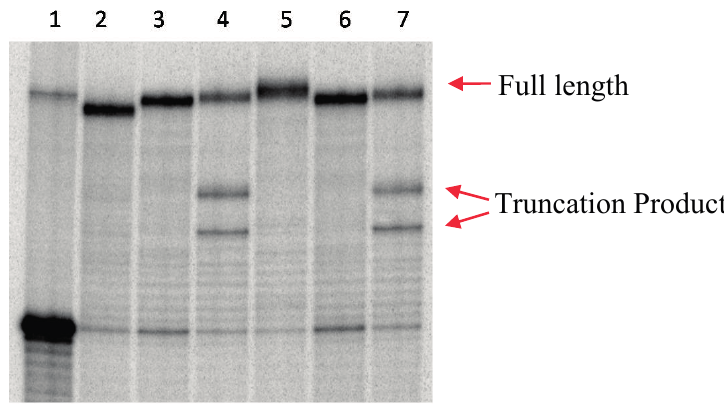
Figure 3. Full length incorporation with T2 and Vent(exo-) DNA polymerase. Lane 1: primer